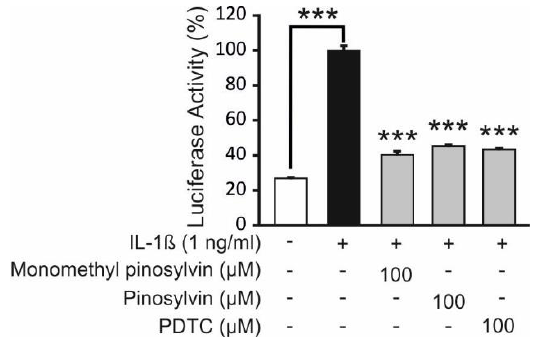
Figure 4. Effects of monomethyl pinosylvin and pinosylvin on NF- k B-mediated transcription in human T/C28a2 chondrocytes transfected with luciferase reporter construct. T/C28a2pGL4.32NFκB cells were stimulated with IL- 1β in the presence of the pine stilbenoids or the known NF- κB inhibitor pyrrolidine dithiocarbamate (PDTC) for 5 h and luciferase activity was measured. Results are presented as mean +SEM, n = 4, *** p < 0.001 as compared to cells incubated with IL- 1β only. The inhibitory effect was similar with ammonium pyrrolidine dithiocarbamate (PDTC), a known NF- κB inhibitor.